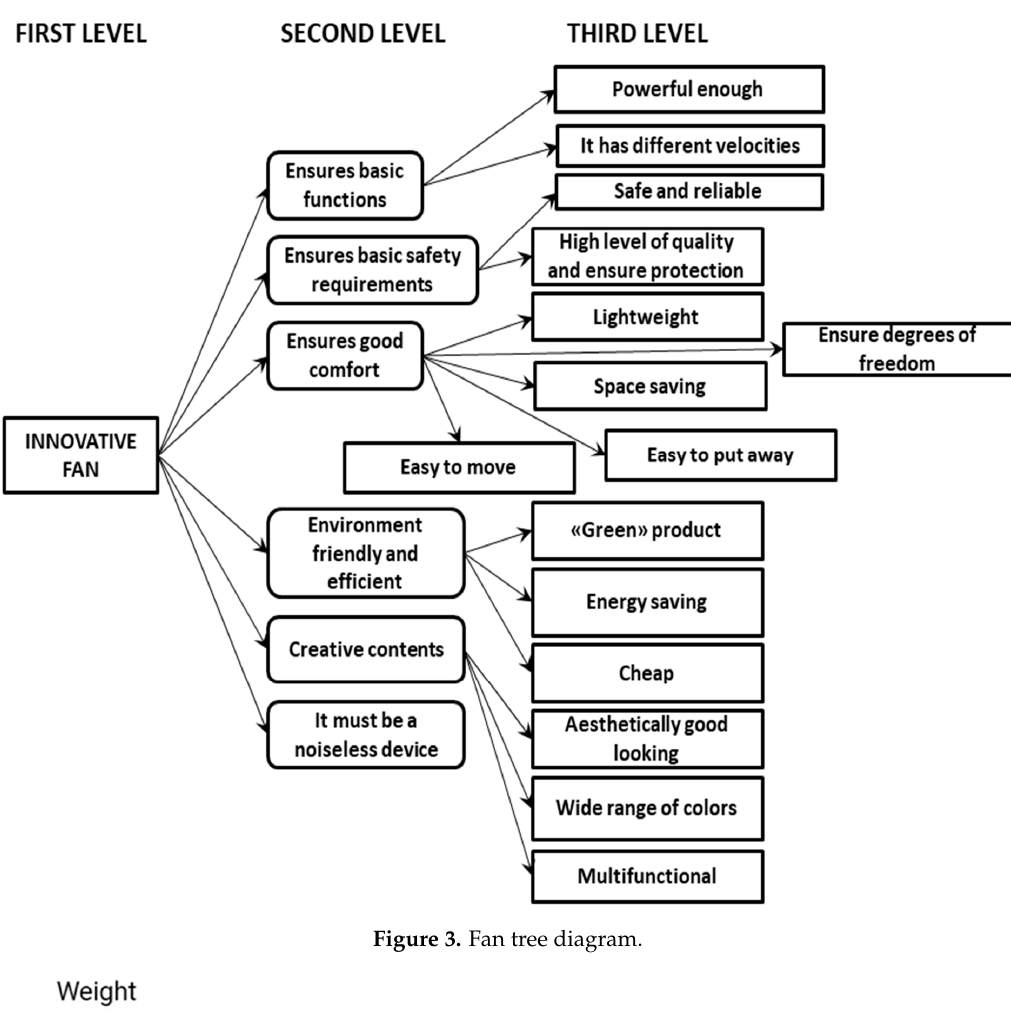
Appl. Sci. 2018 , 8 , x FOR PEER REVIEW Figure 3. Fan tree diagram. Figure 3. Fan tree diagram.